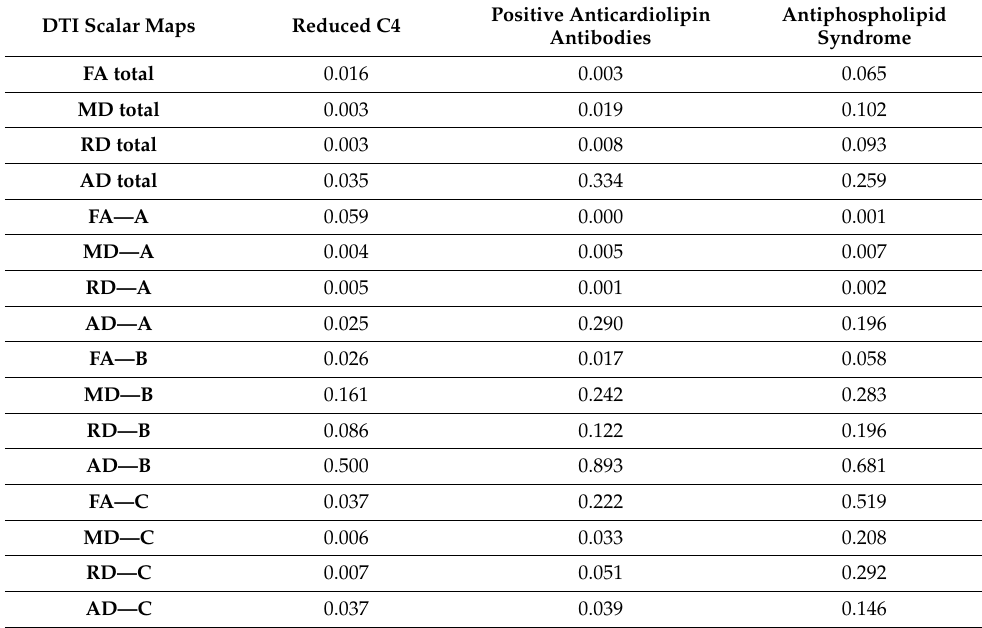
Table 3. DTI scalar maps and association with reduced C4, the presence of anticardiolipin antibodies, and antiphospholipid syndrome. Statistical test: